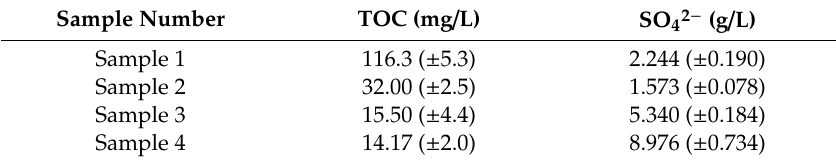
Table 1. Characteristics of the liquid phase separated from the mixed phase with